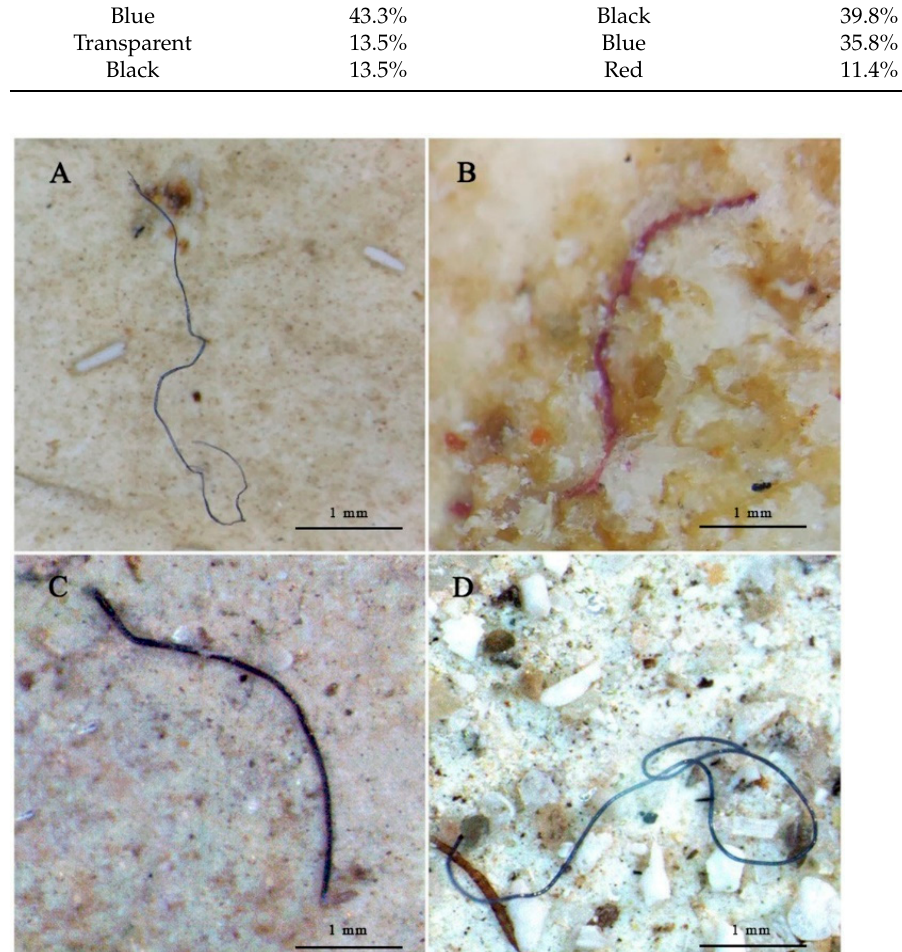
Figure 1. Representative MP particles found in the gastrointestinal tract of H. tubulosa ( A , B ) and representative MP particles found in the sediments ( C , D ): ( A ) blue fiber particle; ( B ) pink fiber particle; ( C ) black fiber particle; ( D ) black fiber particle. Scale bar represents 1 mm.